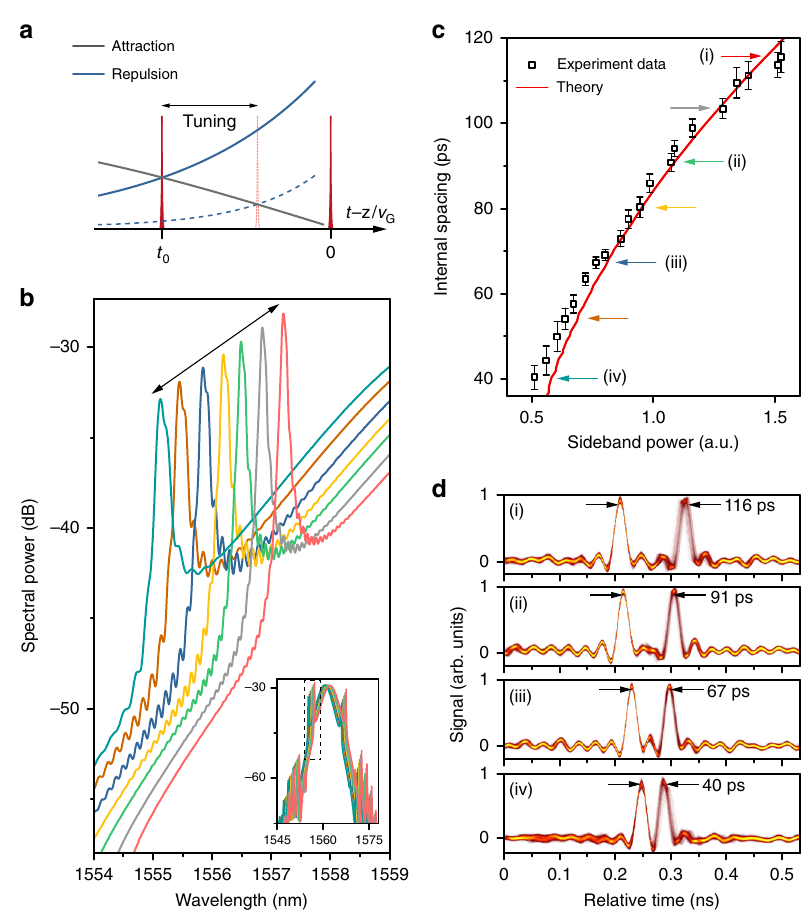
Fig. 4 Continuous tuning of the long-range forces between optical solitons. a Tailoring the pulse spacing within each unit of the supramolecular structure by varying the long-range, inter-soliton forces. b Showing how the spectral intensity in the fi rst higher-frequency sideband decreases when the cavity loss is increased; the inset shows that the overall soliton bandwidth is almost independent of cavity loss. c The dependence of the soliton spacing on the side-band intensity. The experimental data-points, plotted as black squares (standard deviations are shown as error bars), agree well with the red theoretical curve (see Supplementary Note 2 and Note 9). d Four typical persistence-mode traces of the soliton supramolecule during the spacing tuning process, corresponding to the data-points (i), (ii), (iii), and (iv) in c